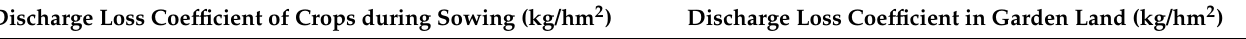
Table 1. Nitrogen and phosphorus discharge loss coefficients from the planting industry in Gansu